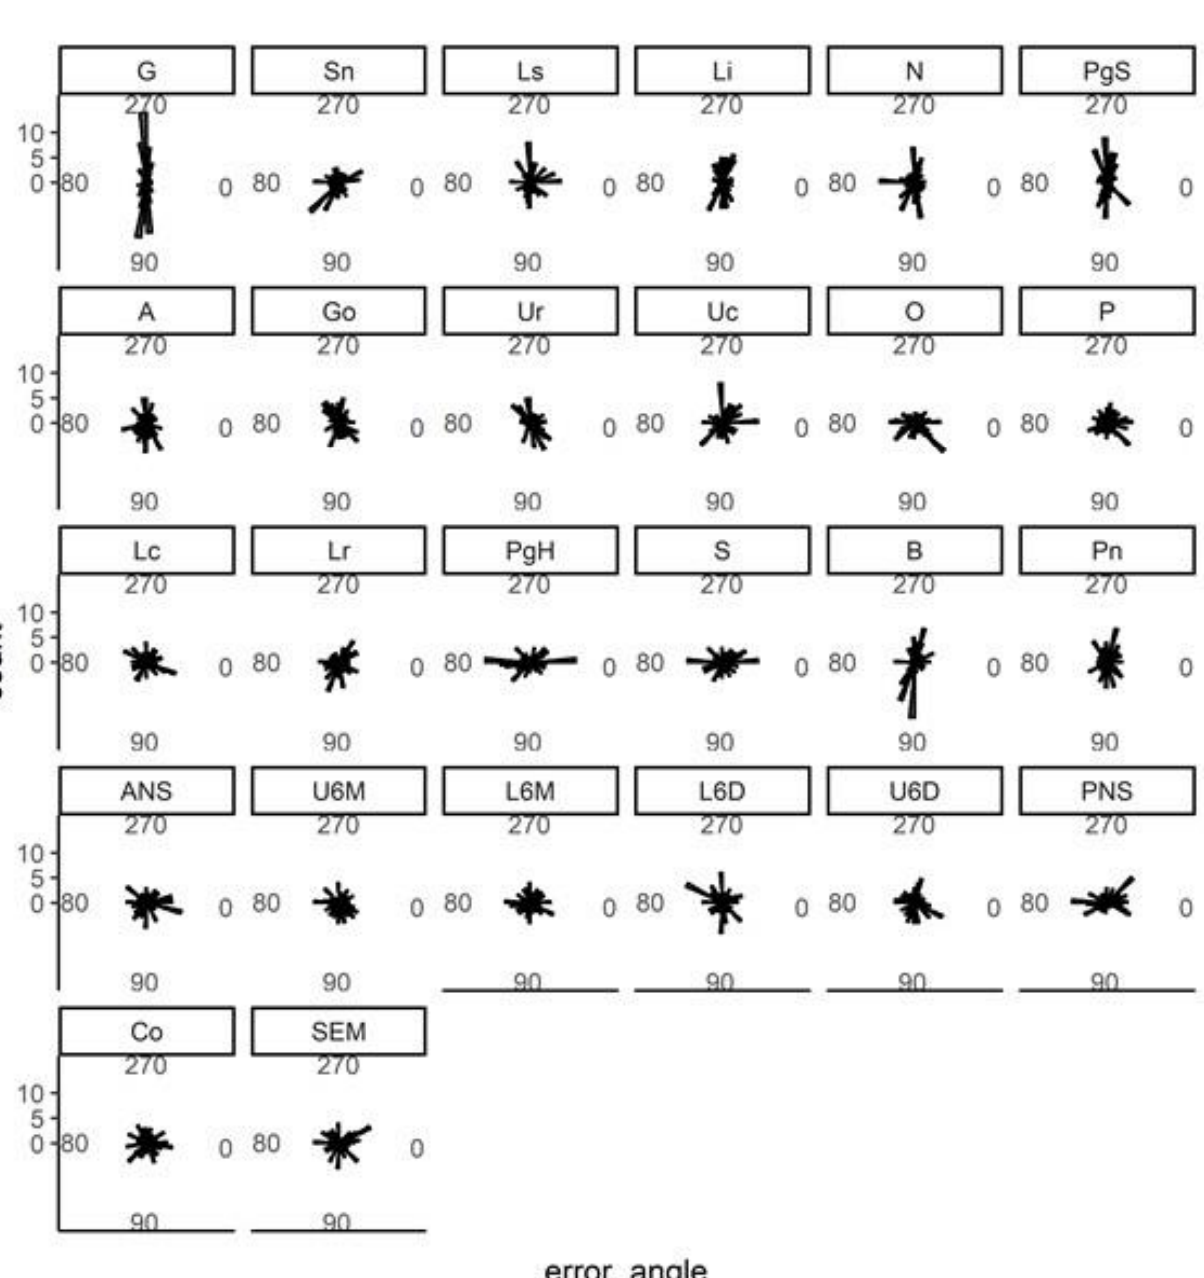
Figure 7. Directionality of the prediction errors of each landmark. Each panel shows the angular distribution of the prediction error in degrees (x-axis) for each of the 26 landmarks.